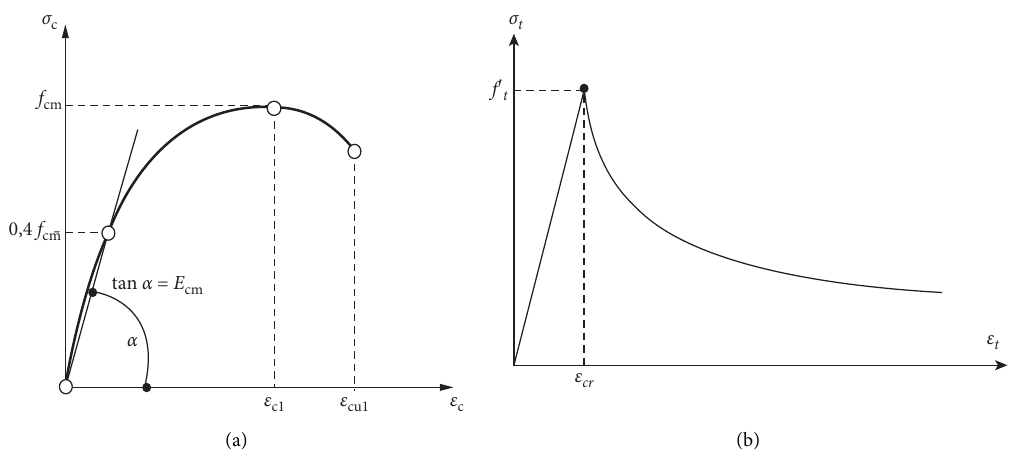
Figure 2: Uniaxial stress-strain of concrete [14]. (a) Compressive stress-strain and (b) tensile